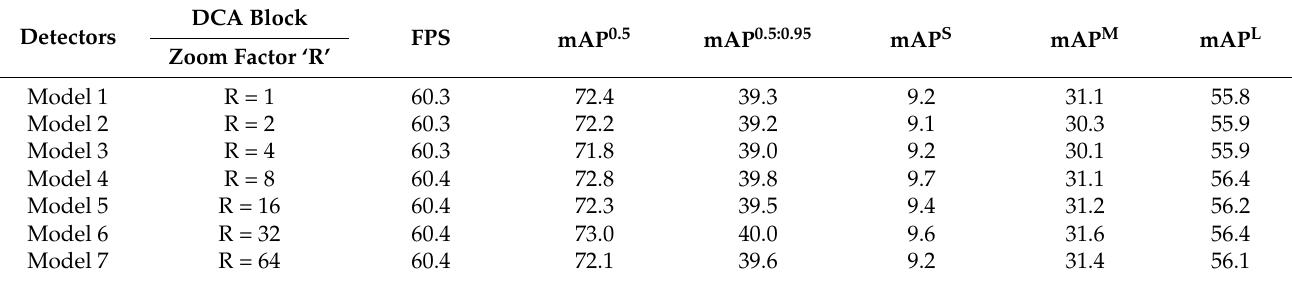
Table 4. Results of different zoom factor ‘R’s in DCA Block.